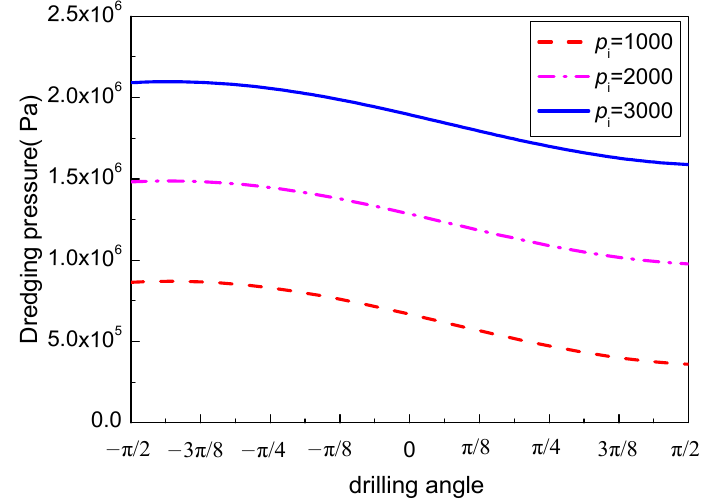
Figure 8. Curves of the relationship between the dredging pressure and the drilling angle under different confining pressures.